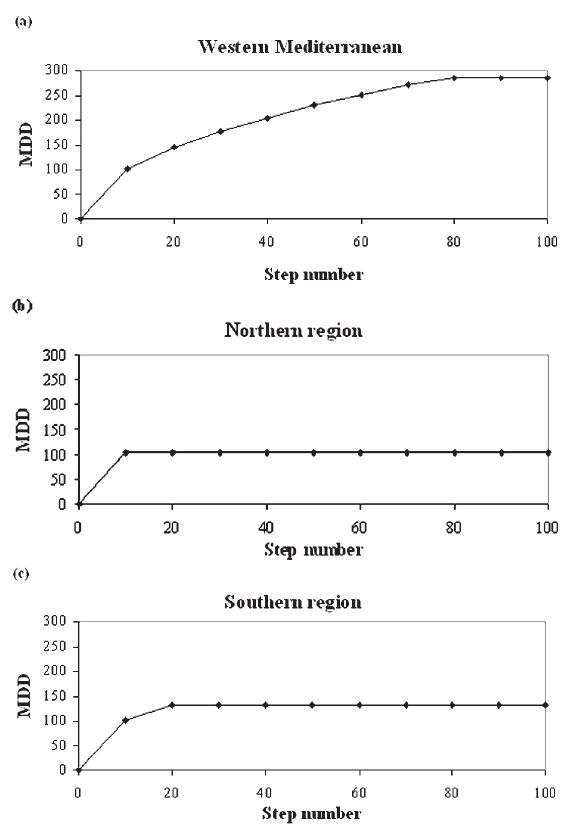
Fig . 2. – Expected MDDs of a population of loggerhead sea turtles dispersing over (a) the western Mediterranean, (b) the northern re- gion and (c) the southern region of the western